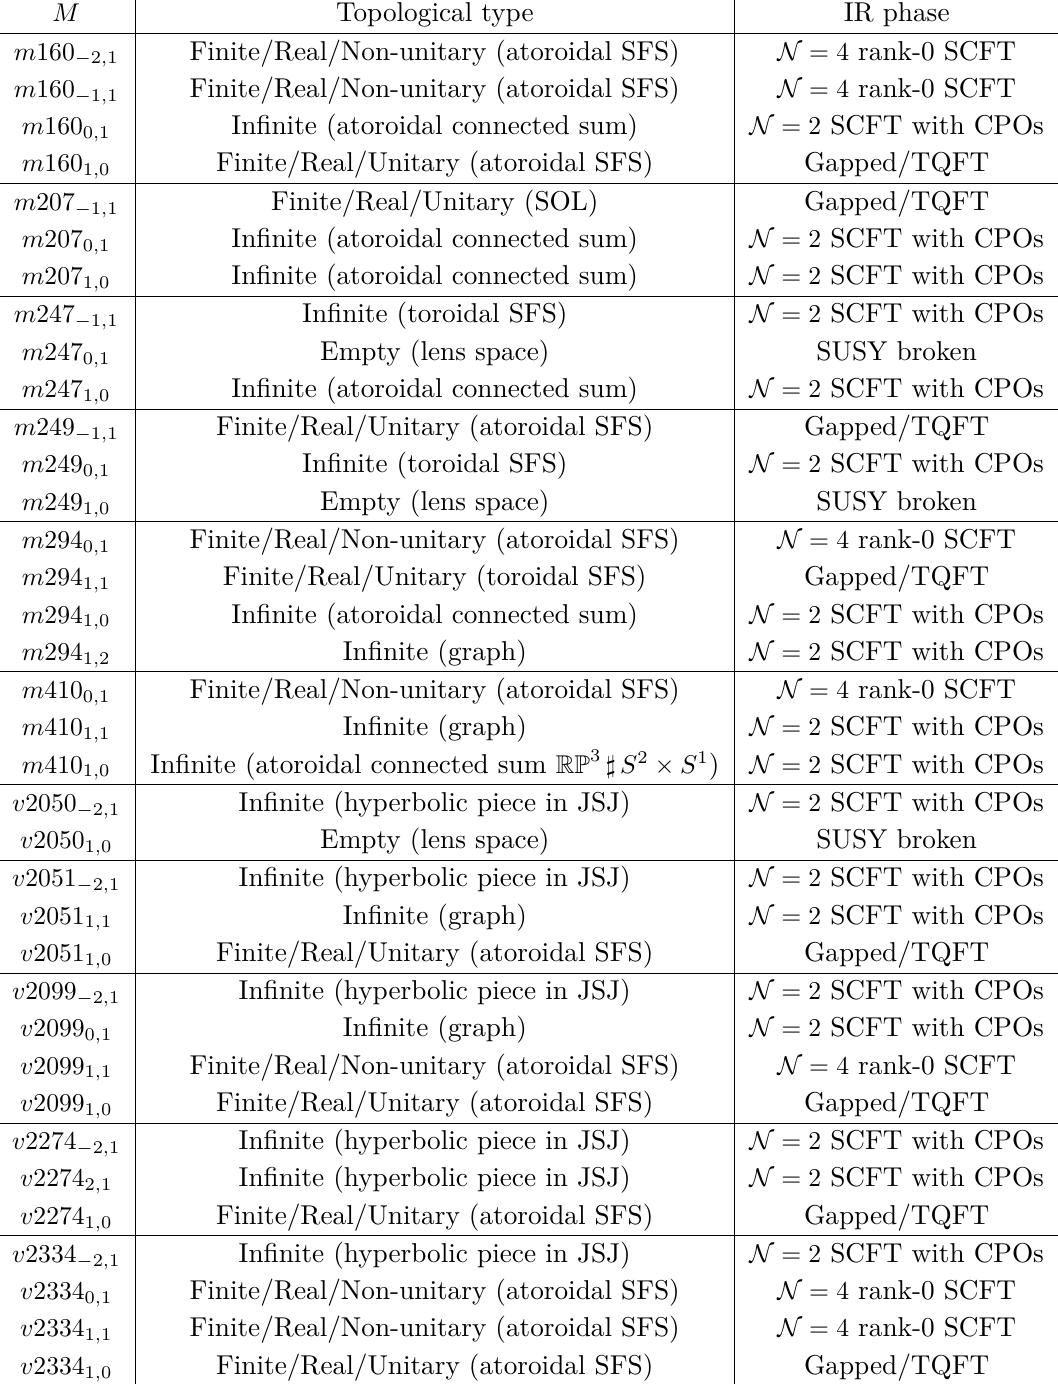
Table 3. Topological types of non-hyperbolic 3-manifolds obtained by exceptional Dehn fillings and the IR phases for the associated class R theories. Here N . Refer to [8] for the topological types of the non-hyperbolic 3-manifolds in the N PA SP + QB SP conventional mathematical classification